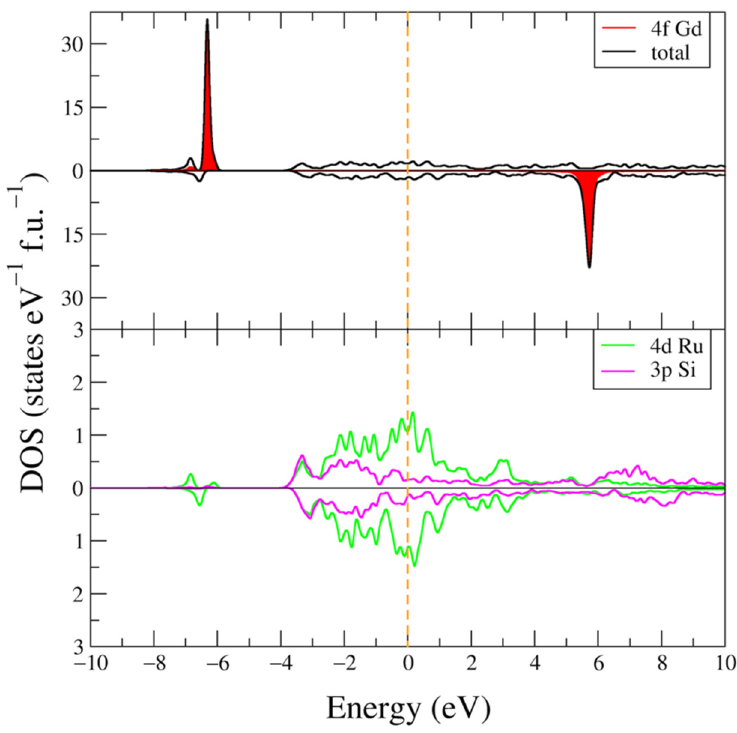
Figure 4. Calculated total (black curves) and partial densities of states of GdRuSi. The Fermi energy (E F ) is set at zero and shown as a vertical dashed orange line.